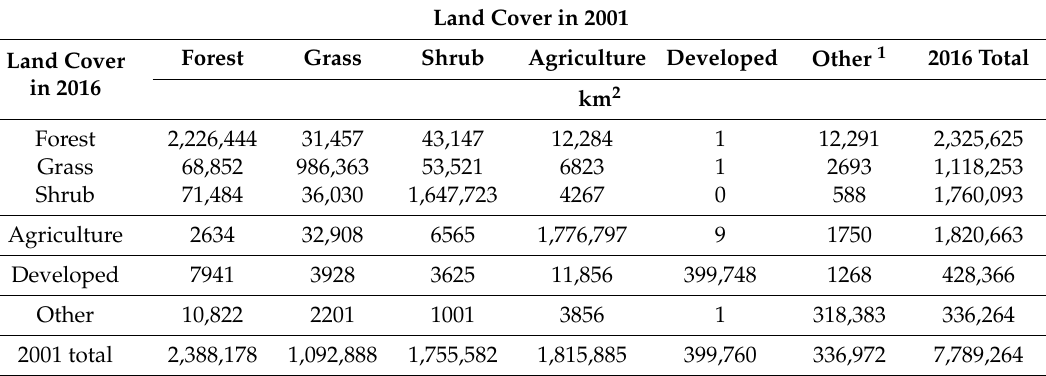
Table 1. Land cover change in the continental United States (CONUS), 2001 to 2016. The original 16 NLCD land cover classes were generalized to the six shown here; see Homer et al. (2020) for additional